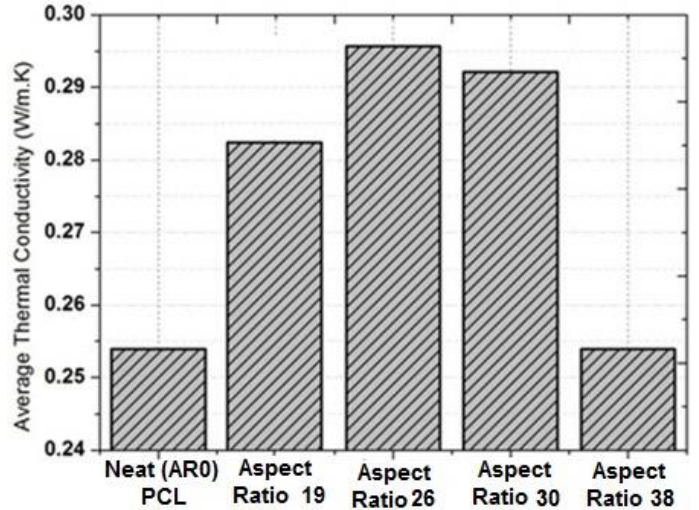
Figure 7. Comparative average thermal conductivities of the 5 samples.